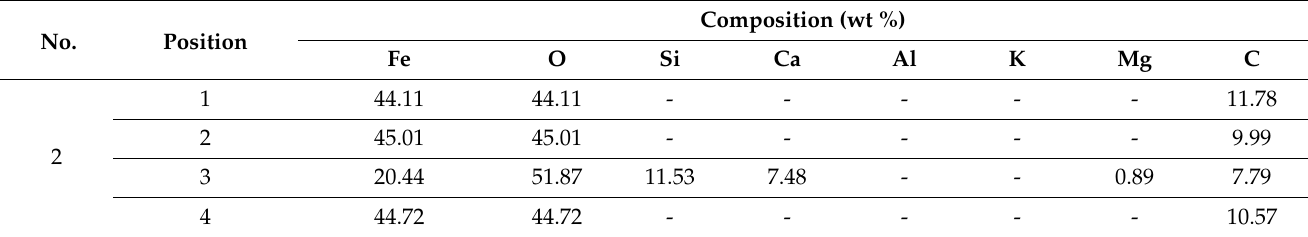
Table 3. EDS analysis of flake hammer scale (No. 2).